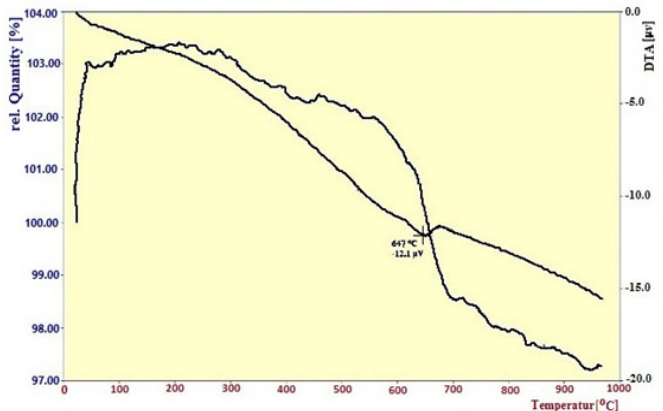
Fig. 2. TGA and DTA curves of Sm